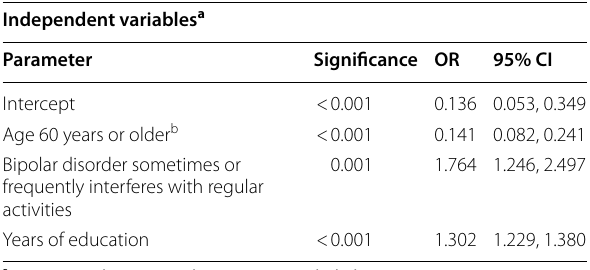
Table 2 Explanatory model based on